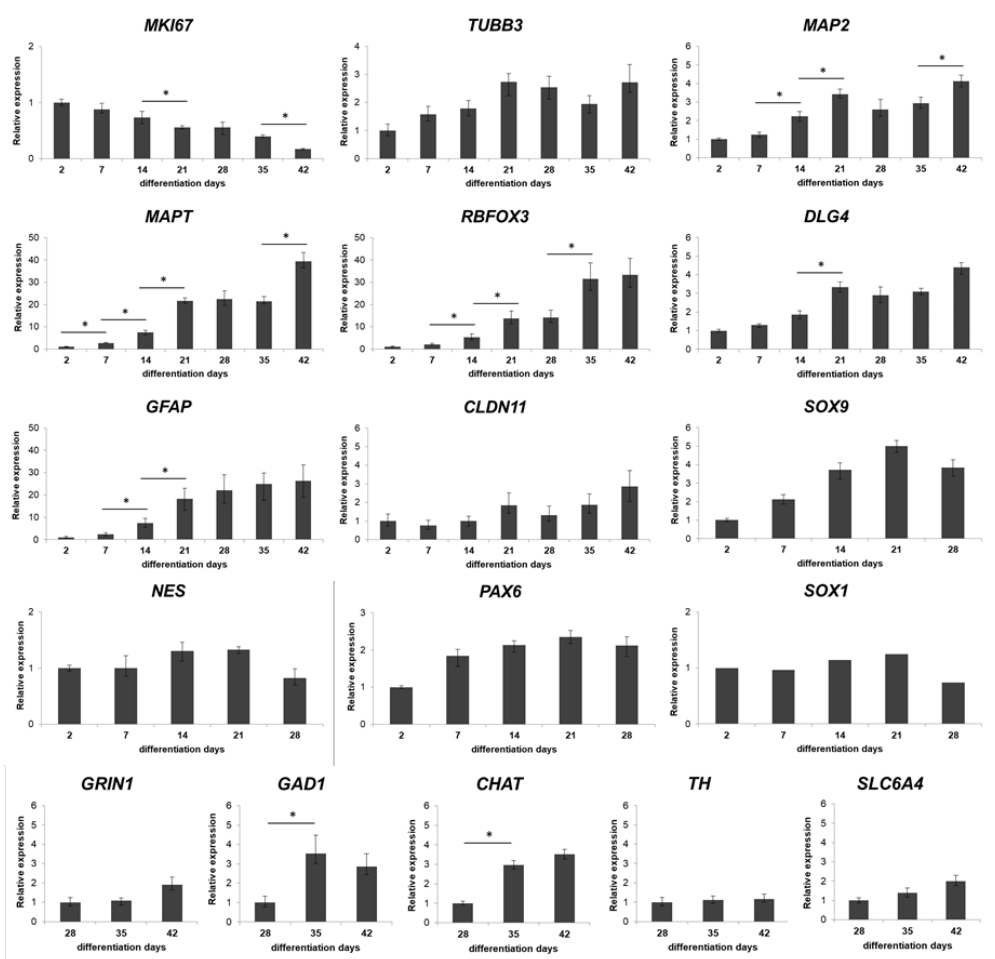
Figure 3. Real-time PCR measurements of relevant markers during the neuronal di ff erentiation of the spheroids. Twelve 3D spheroids were pooled, lysed with RLT-bu ff er and used in RT-PCR analysis at each timepoints. Where the genes are already expressed in D2 samples, it is referred as 1. Day 2, 7, 14 and 21 values for GRIN1, CHAT, TH, GAD1, and SLC6A4 are not indicated as these genes were not expressed at those time points. Graphs represent normalized relative expression values, analyzed for each gene using the ddCT method [41]. Mean values and ± SEM of three biological replicates ( n = 3) are presented on graphs, significance are determined by paired T test ( ∗ p < 0.01). Note that y axis’s scales alter according to the di ff erent relative expression